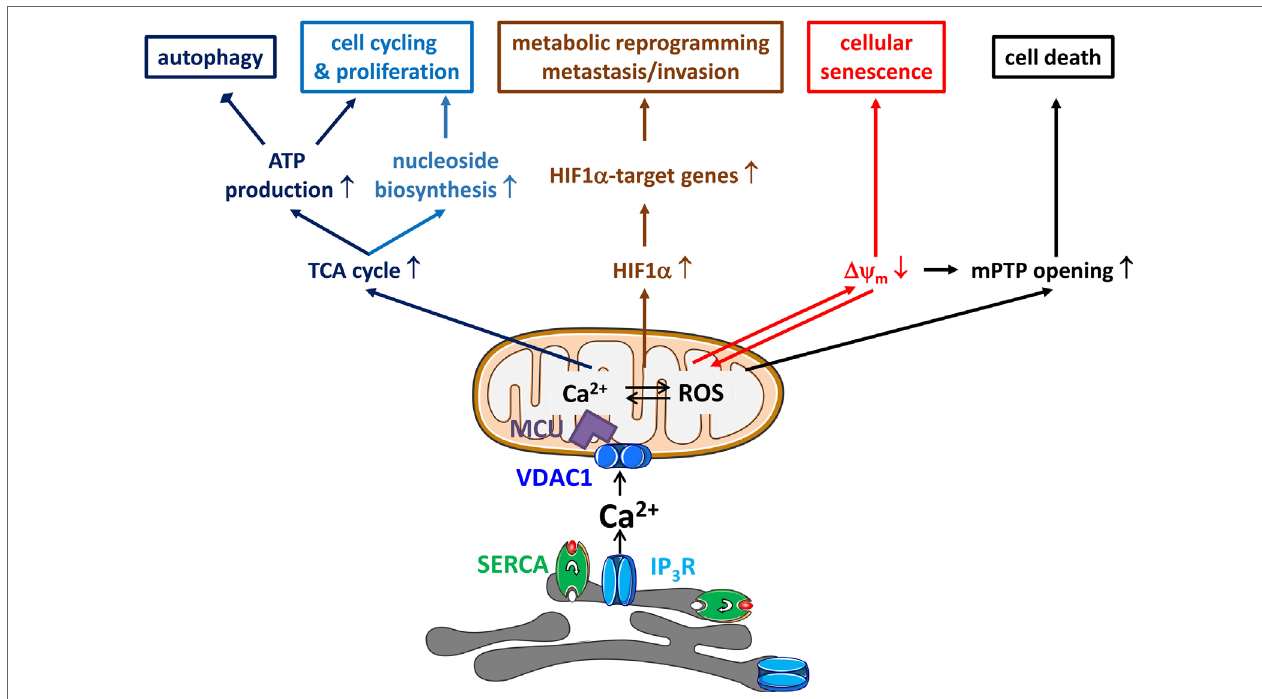
FiGURe 1 | endoplasmic reticulum (eR)–mitochondrial Ca 2 + transfers in cancer hallmarks . ER–mitochondrial Ca 2 + transfers will impact several hallmarks of cancer. First, ER-originating, inositol 1,4,5-trisphosphate receptor (IP 3 R)-driven Ca 2 + signals delivered to the mitochondria will drive the tricarboxylic acid (TCA) cycle, which will not only result in ATP production via NADH and the electron transport chain but also in the production of mitochondrial substrates shuttled to biosynthetic pathways for macromolecules like nucleosides. This is accompanied by a decrease in autophagic flux due to a low activity of AMP-activated kinase. Second, mitochondrial Ca 2 + signals will also increase mitochondrial reactive oxygen species (ROS) production, which will drive the transcription of the mitochondrial Ca 2 + uniporter (MCU) regulates breast cancer progression via hypoxia-inducible factor 1 α (HIF1 α )—target genes with functions in metabolic reprogramming and, metastasis and invasion. Third, ER–mitochondrial Ca 2 + fluxes are involved in mediating cellular senescence induced by oncogenes and replication. The mechanism involves the partial depolarization of the mitochondrial potential ( Δψ m ) and accumulation of ROS. Fourth, ER–mitochondrial Ca 2 + fluxes impact cellular sensitivity toward apoptotic stimuli. In particular, mitochondrial Ca 2 + overload, together with the accompanying ROS production, has been a critical factor for mitochondrial permeability transition pore (mPTP) opening. Thus, the cell death-inducing properties of several chemotherapeutics actually critically depend on their ability to elicit mitochondrial Ca 2 + overload. Thus, ER–mitochondrial Ca 2 + transfers display both oncogenic properties (cell cycling, proliferation, metabolic reprogramming, metastasis, and invasion) and tumor suppressive properties (reduced autophagy and increased cell death